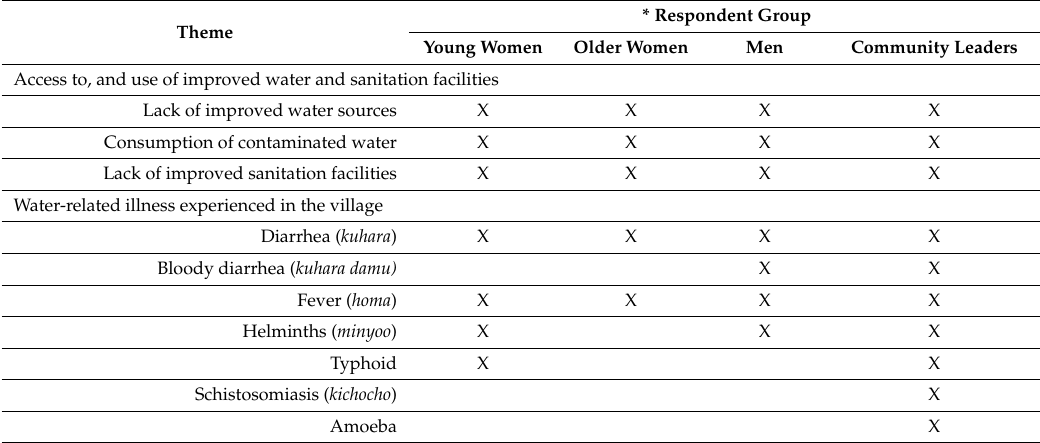
Table 2. Summary of themes emerging from focus group discussions in Geita region Tanzania, by respondent